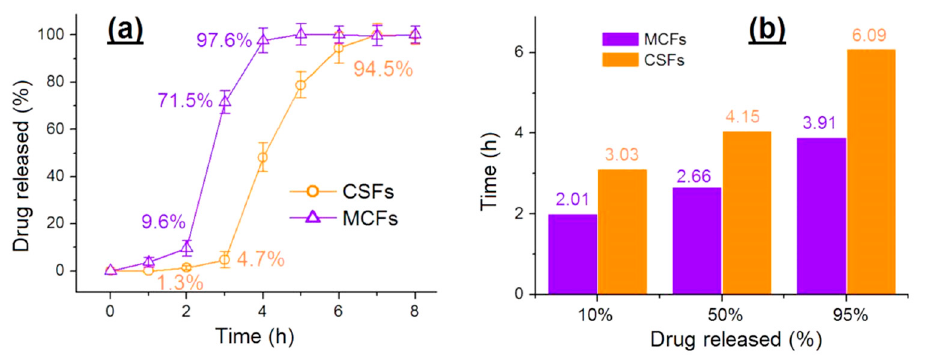
Figure 8. The in vitro drug-release performances: ( a ) Accumulative aspirin release as a function of drug-release time points; and ( b ) the time needed for achieving a certain percentage of aspirin loaded in the prepared nanofibers.